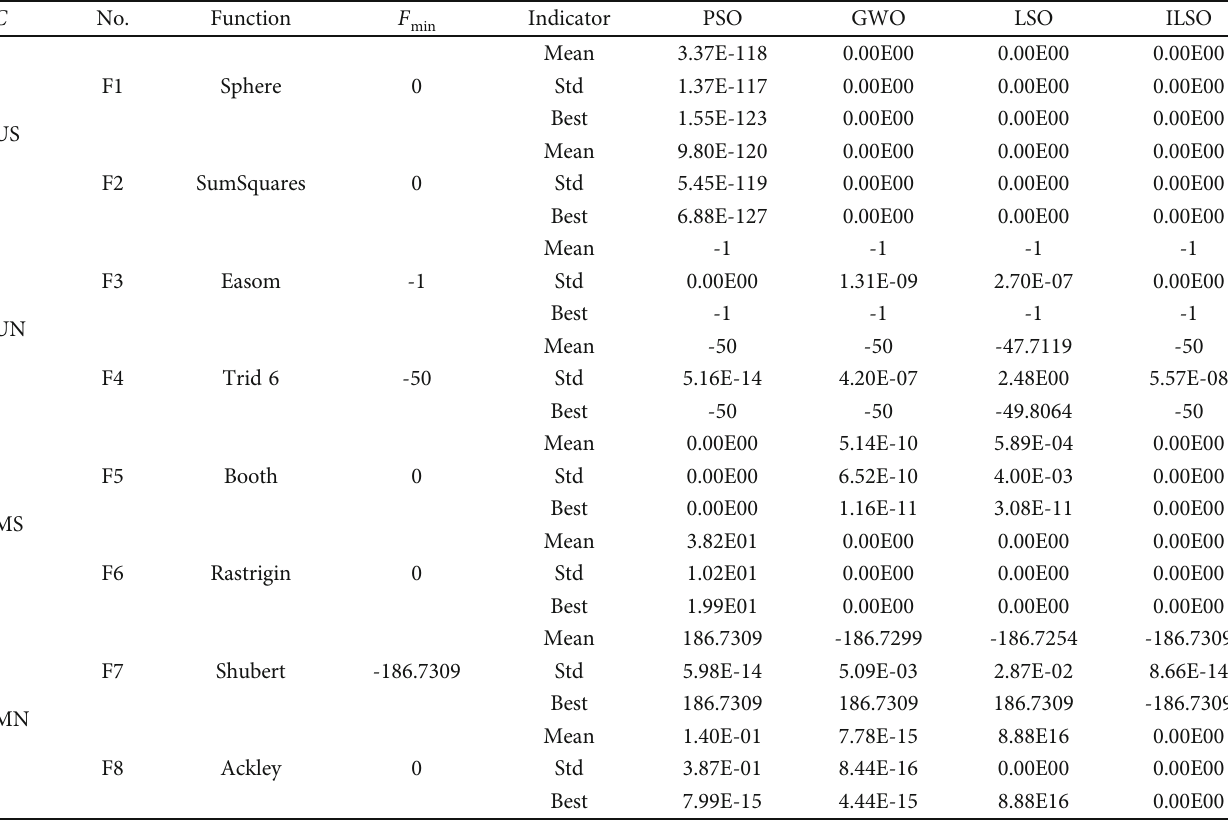
Table 3: Performance comparison of 4 algorithms on 8 benchmark